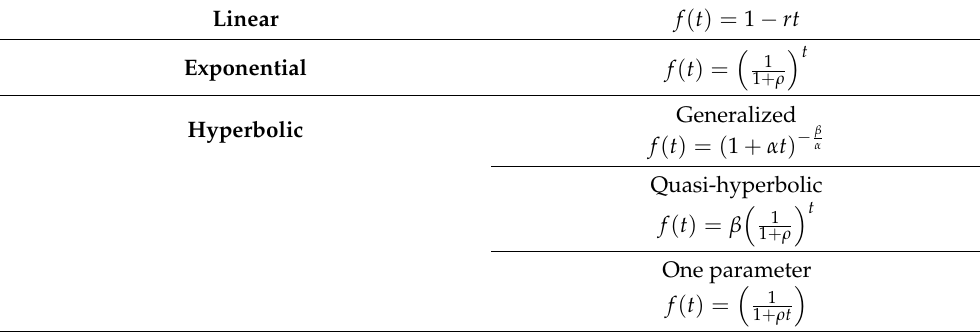
Table 1. Common discount functions in intertemporal choice reported by [8], p. 426.